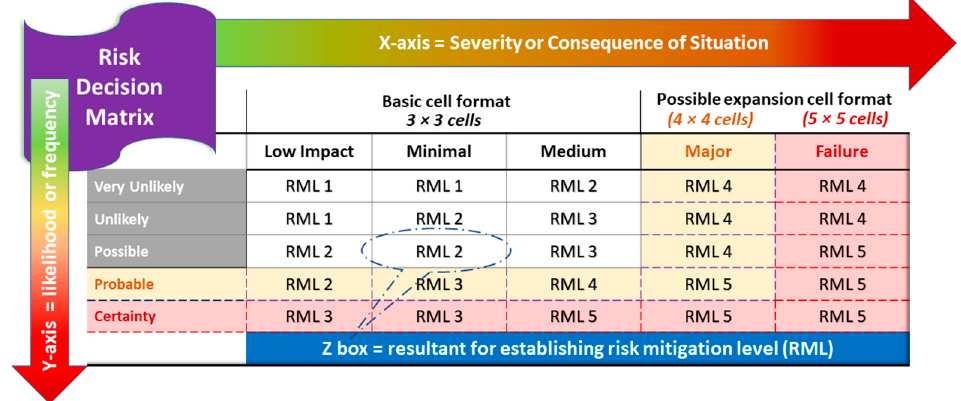
Figure 2. Risk decision matrix conceptual framework illustrating a basic 3 × 3 cell format (white cells) with options for expanding to a 4 × 4 cell format (using added yellow cells) or further expansion to a 5 × 5 cell format (using added red cells).